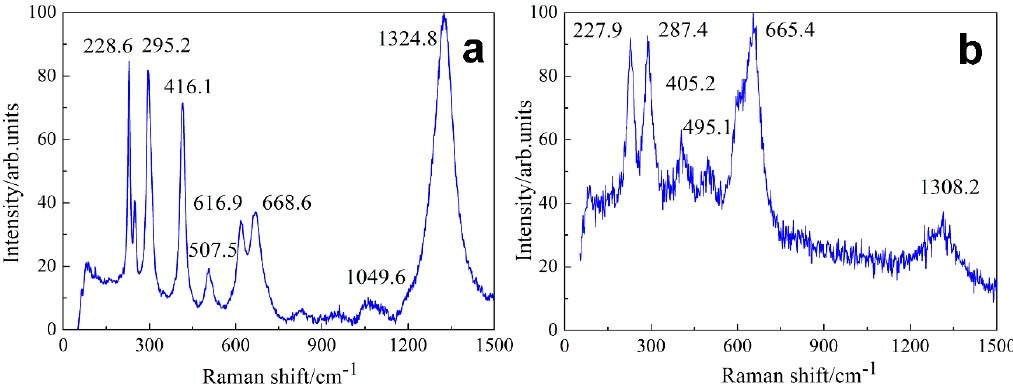
Figure 7. Raman spectrum of wear scar of DLC films/silicon films under different temperatures: ( a ) ball; ( b ) disc.